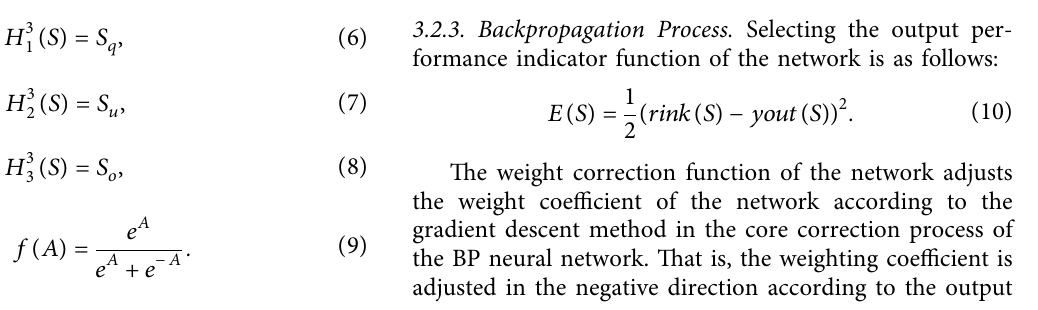
Figure 5: Nanomaterials characterization techniques.